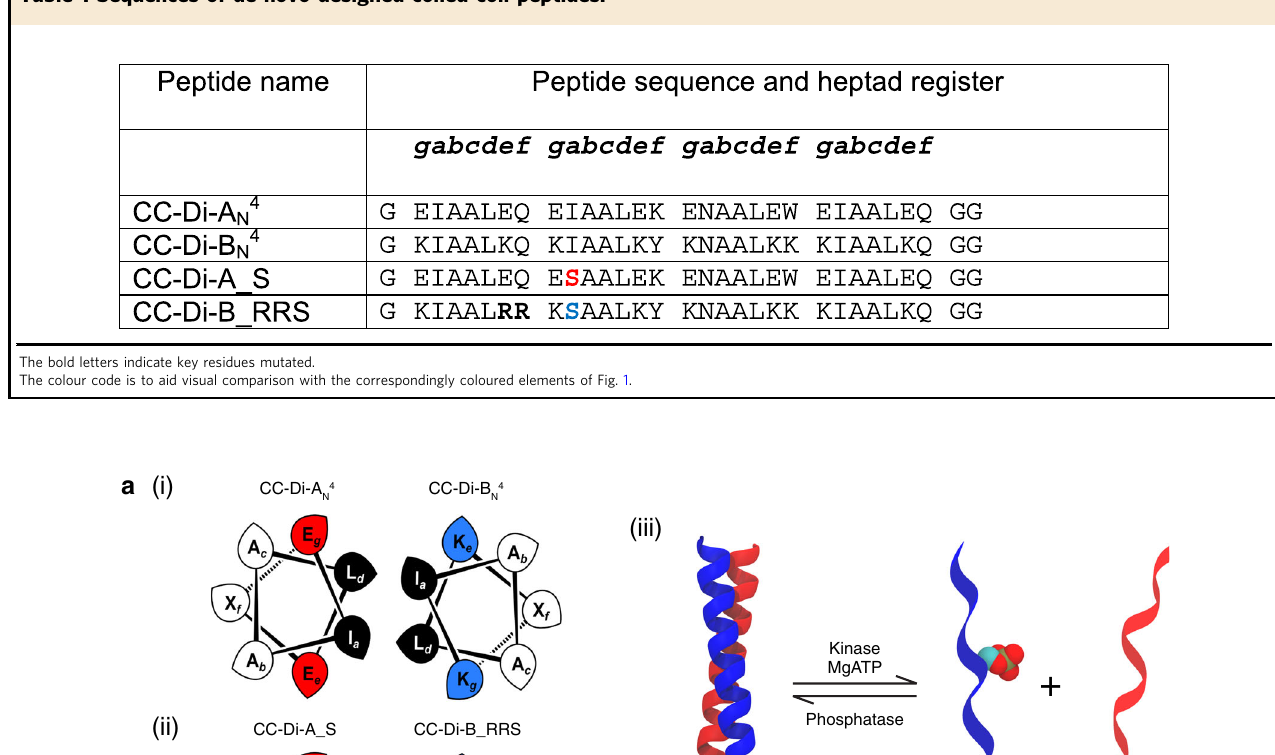
Table 1 Sequences of de novo designed coiled-coil peptides.